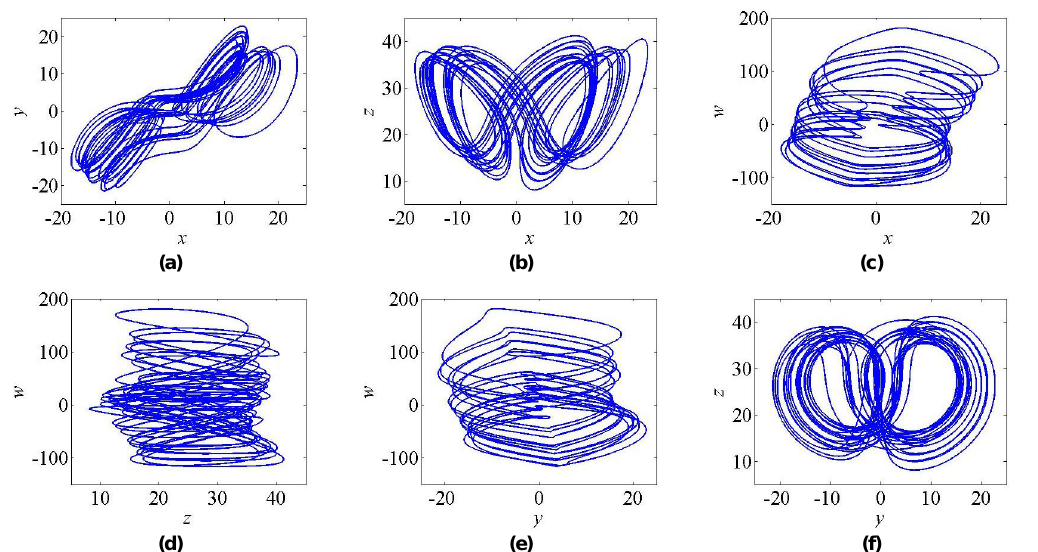
Figure 1. Attractors of hyper chaotic Lorenz system. ( a ) x–y plane, ( b ) x–z plane, ( c ) x–w plane, ( d ) z–w plane, ( e ) y–w plane and ( f ) y–z